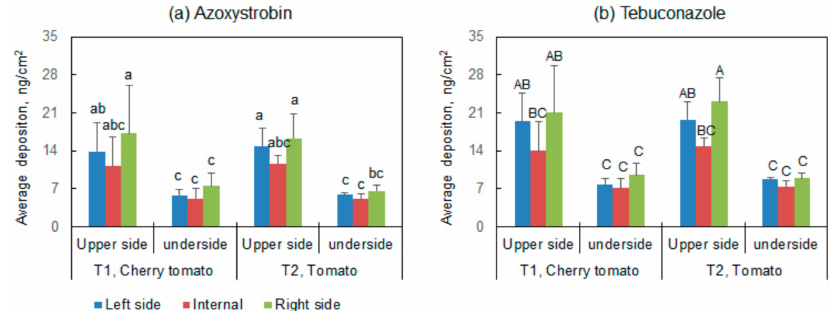
Figure 3. Average depositions of ( a ) azoxystrobin and ( b ) tebuconazole per unit filter paper on the left side, internal, and right side of the upper side and underside leaves (bars with different letters are significantly, Duncan’s test, p <